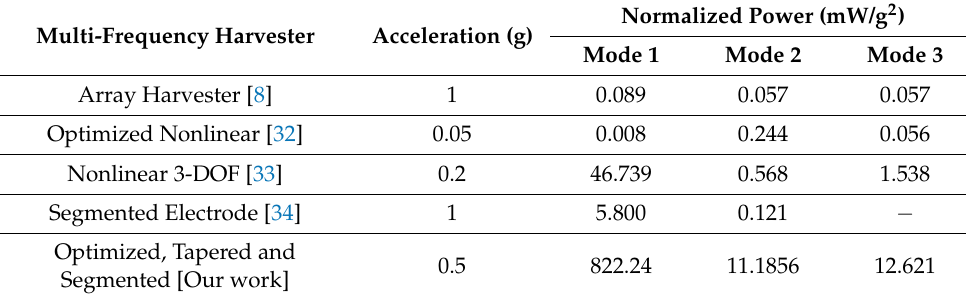
Table 7. Comparison of different multimode harvester